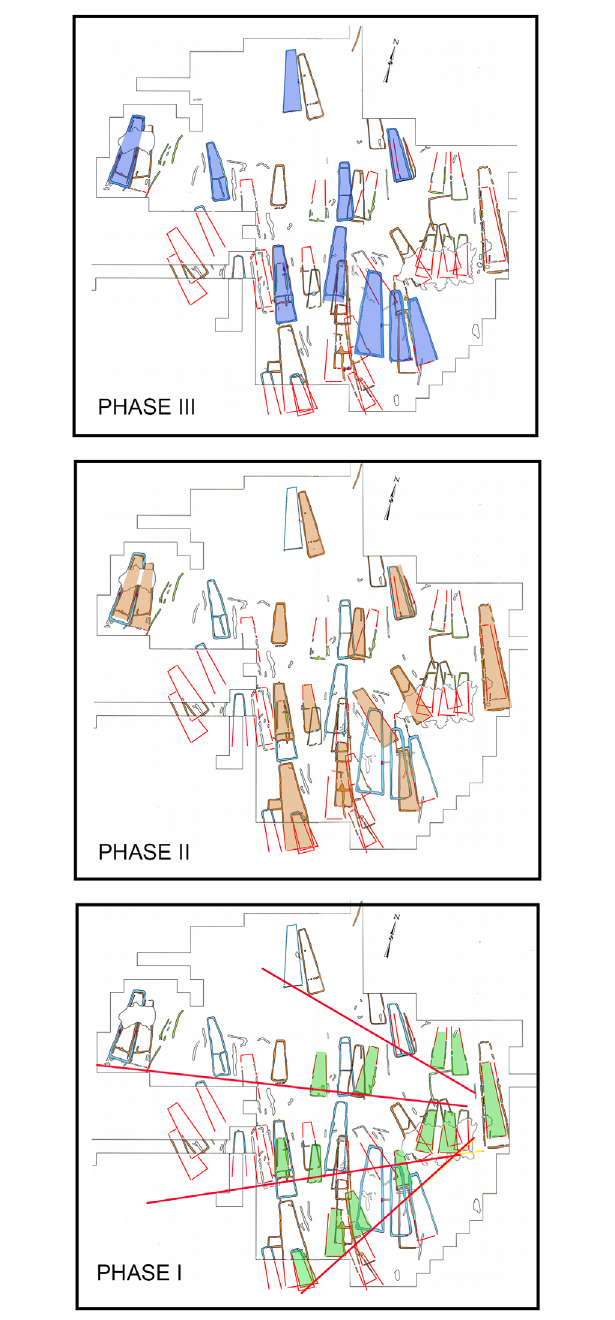
Fig. 6. Brześć Kujawski 4. Settlement plan divided into three main phases. According to Grygiel 2008, modified by the